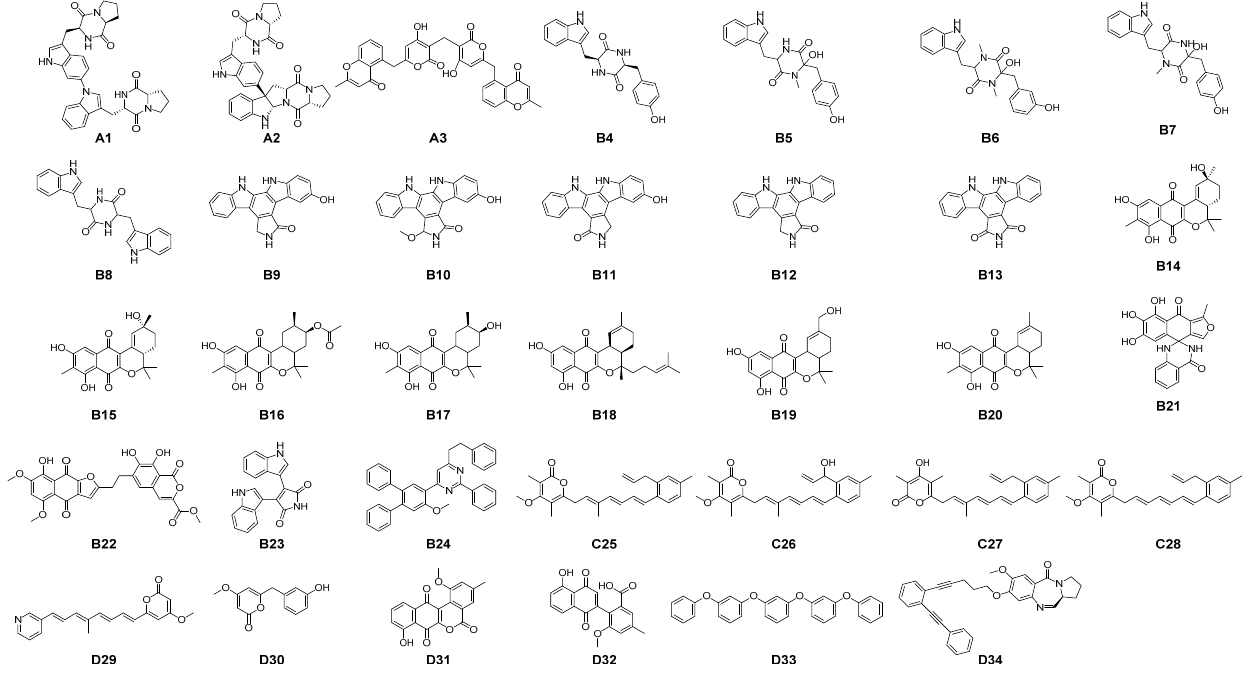
Figure 7. Chemical structures of the compounds with the best binding scores.